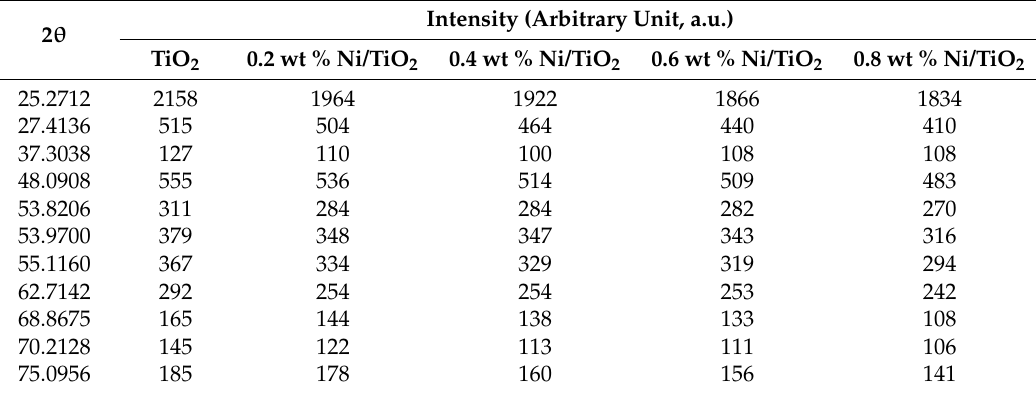
Table 2. Intensity of all peaks of TiO 2 and Ni/TiO 2 .